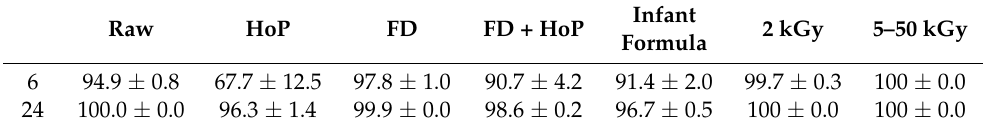
Table 2. Percentage of growth inhibition of S. aureus in gamma irradiated FD-DHM samples. Growth inhibition measured by comparison to optimal growth in LB broth, and measured after inoculation at the time points 0, 6, and 24 hours. Values are the means ± SD of 2 biological replicates.